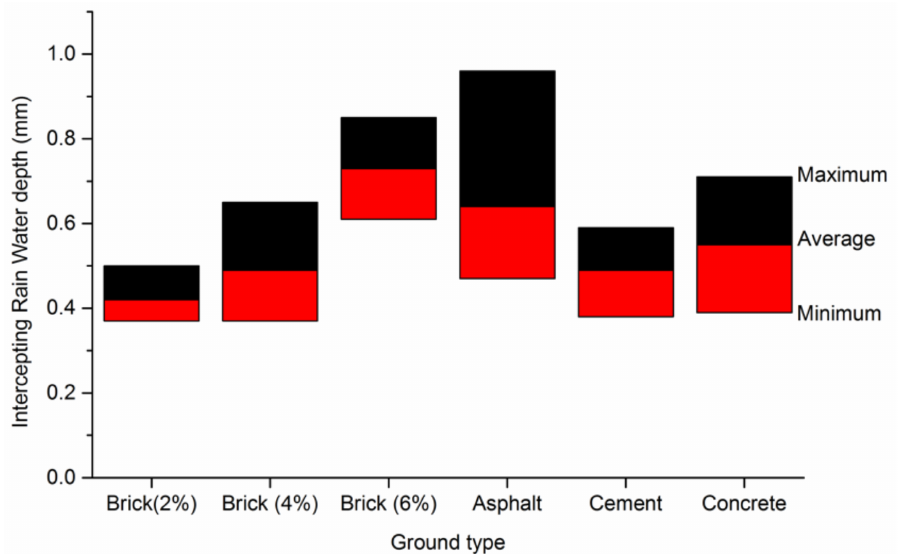
Figure 3. Experimental results of typical impervious surfaces interception.